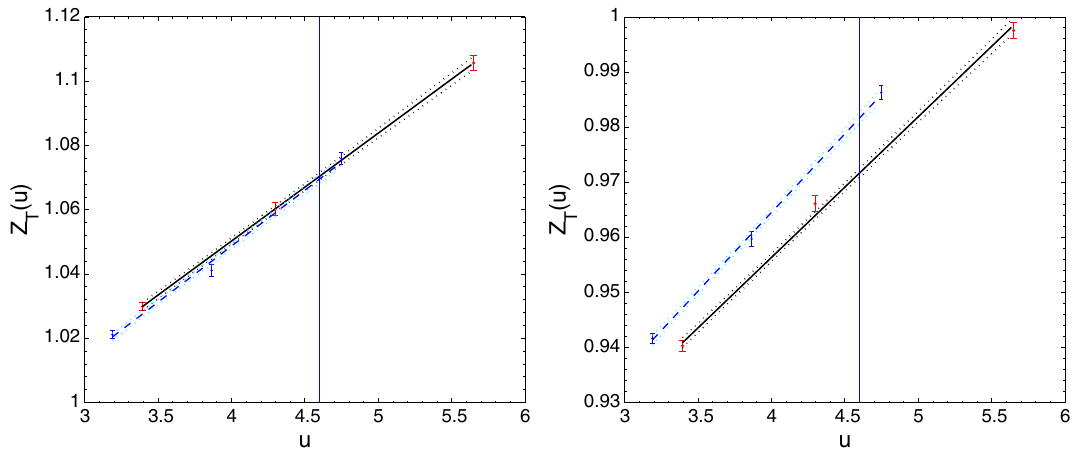
Fig. 11 N f = 2, interpolation to u